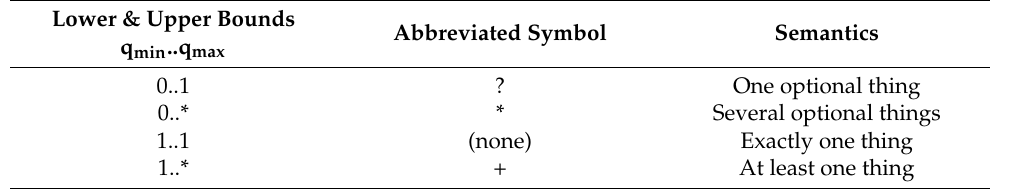
Table 1. Computational object value types